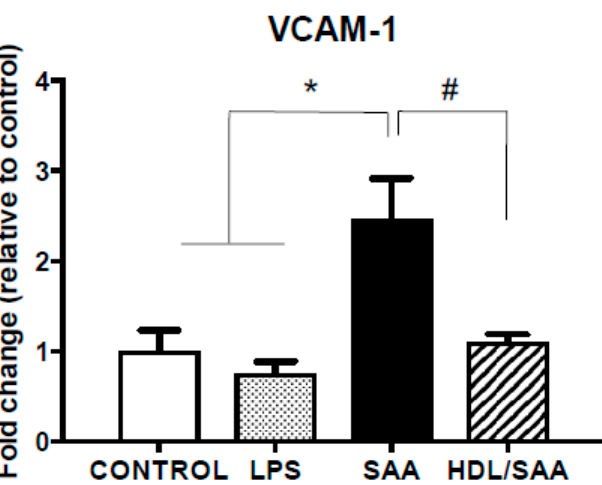
Figure 5. SAA induced increase in VCAM-1 expression in heart tissue is inhibited by pretreatment with HDL. Male ApoE − / − mice were allocated into 4 treatment arms and administered with vehicle (control), LPS, SAA alone, or SAA in combination with HDL. Mice were monitored for 4 weeks after commencement of treatment then sacrificed, and hearts were harvested and processed, as described in the methods section. The extent of relative VCAM-1 mRNA expression was determined in tissue homogenates by qPCR. Data represent mean ± SD of duplicate analyses from control ( n = 6), LPS ( n = 6), SAA ( n = 6), and DL / SAA ( n = 6) mouse hearts. * Increased significantly relative to vehicle and LPS control groups, p < 0.001. # Decreased significantly compared to SAA alone group, p < 0.001.